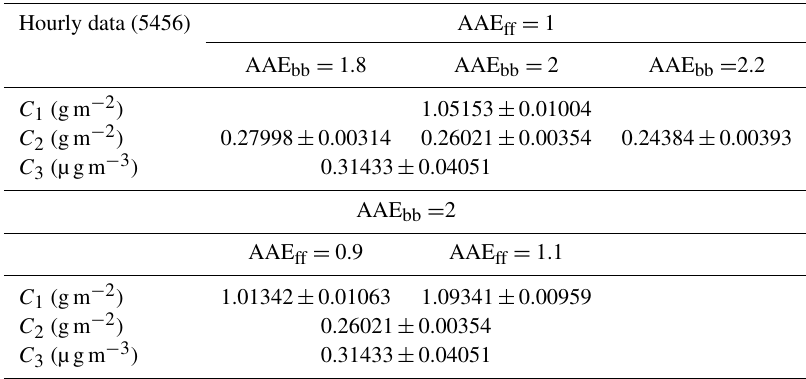
Table 2. C 1 , C 2 and C 3 obtained by MLR on the aethalometer model for different AAE bb (1.8, 2, 2.2), keeping AAE ff = 1 and varying